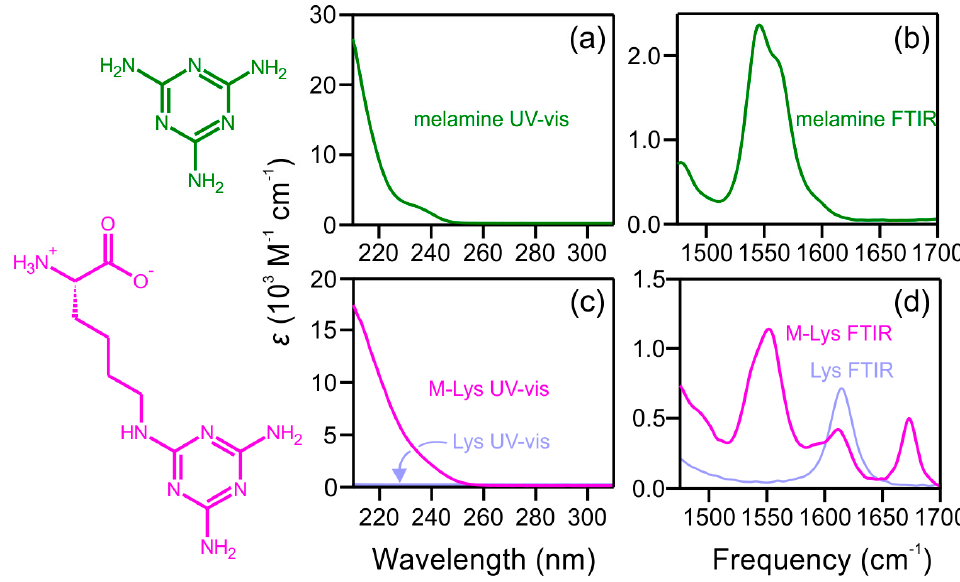
Figure 2. UV-visible absorption spectra of melamine ( a ) and M-Lys ( c ) in neutral D 2 O solution. FTIR spectra for melamine ( b ) and M-Lys ( d ) in neutral D 2 O solution. The UV-visible and FTIR spectra of lysine (light purple) taken under the same experimental conditions are also included. The extinction coefficient ( ε ) is calculated from ε = A /( L · c ), where A is the measured absorbance, L is the optical path length (100 μ m) and c is the concentration of the sample (10 mM).